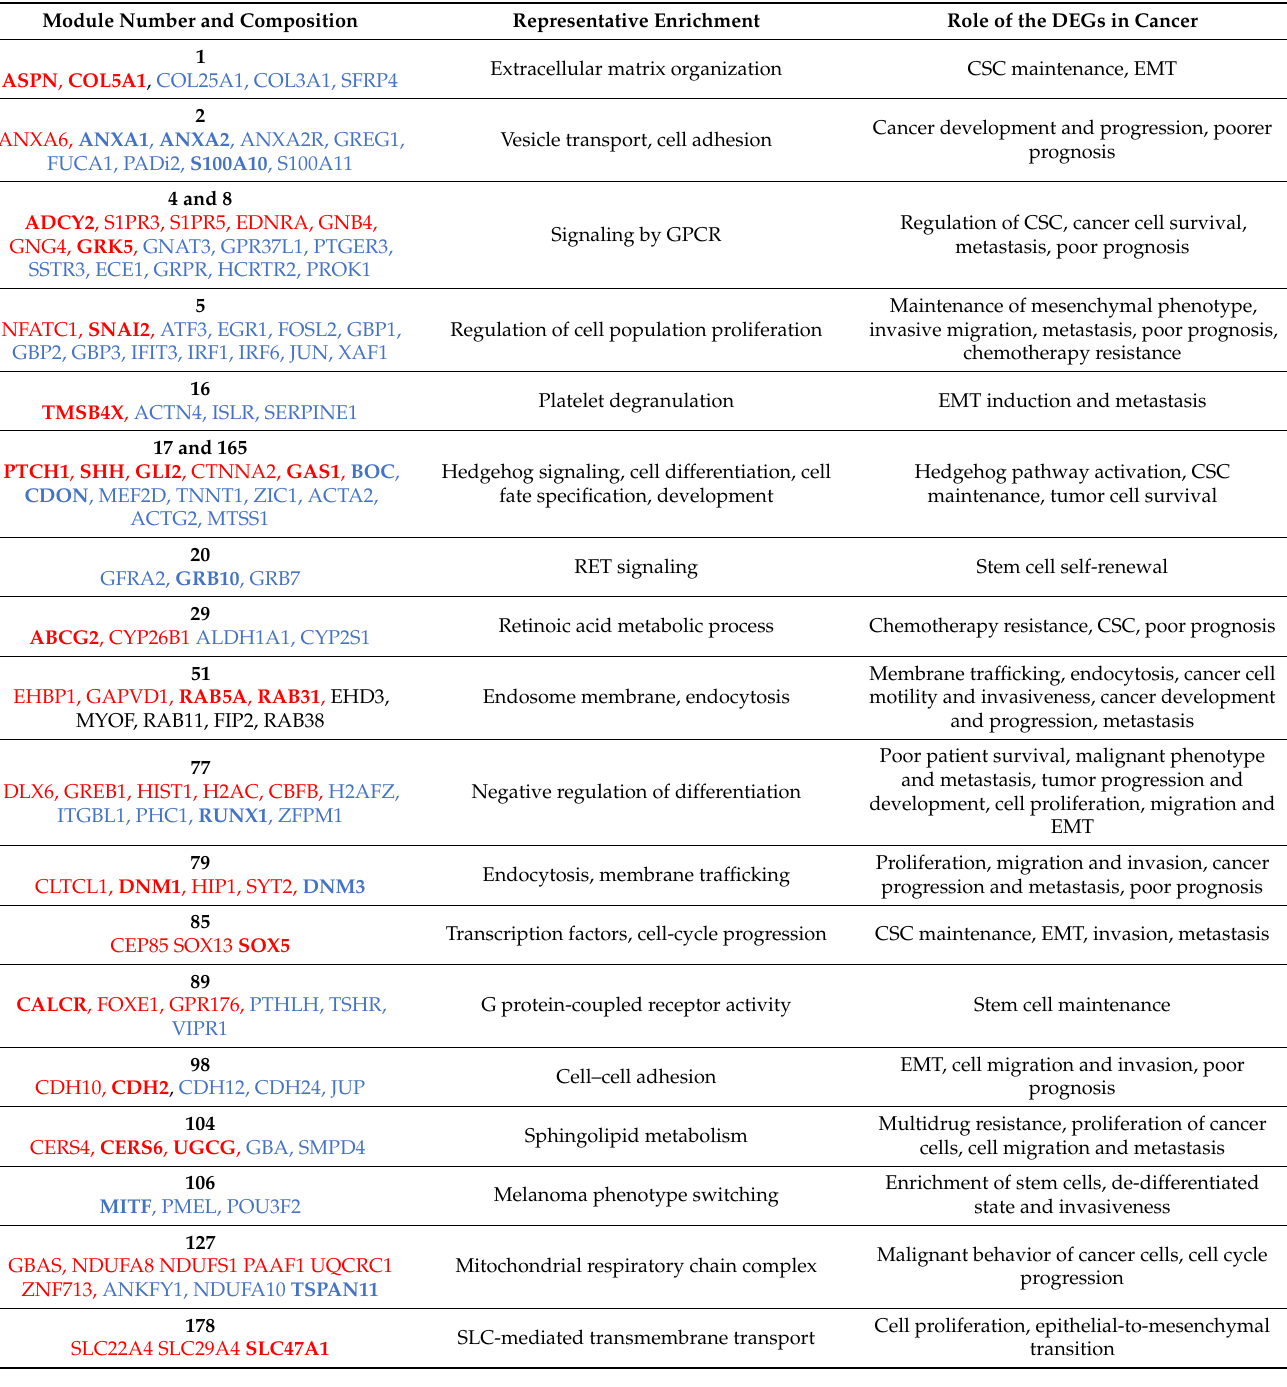
Table 2. Composition of active modules containing one or more of the identified genes of inter- est listed in Table 1 (in bold) with genes upregulated in red and genes downregulated in blue, representative enrichment and role of differentially expressed genes (DEGs) in